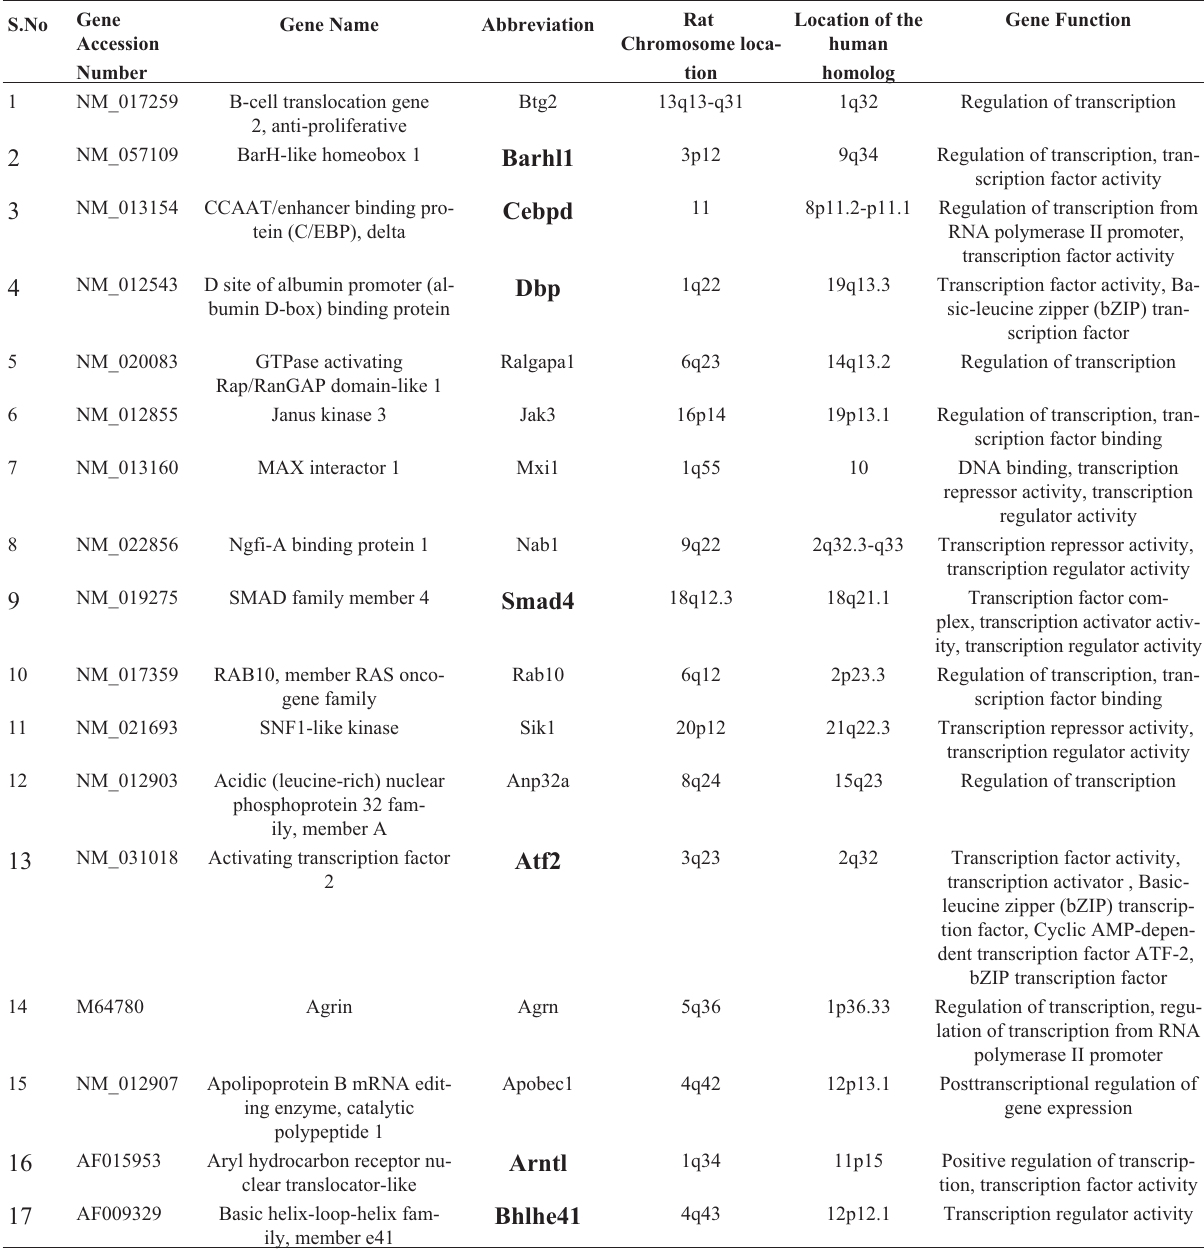
Table 1 - Genes with accession numbers, names and functions and chromosomal location in the rat chromosomes as well as the chromosomal location of the human homologs. Known and putative transcription factors are bold-faced.